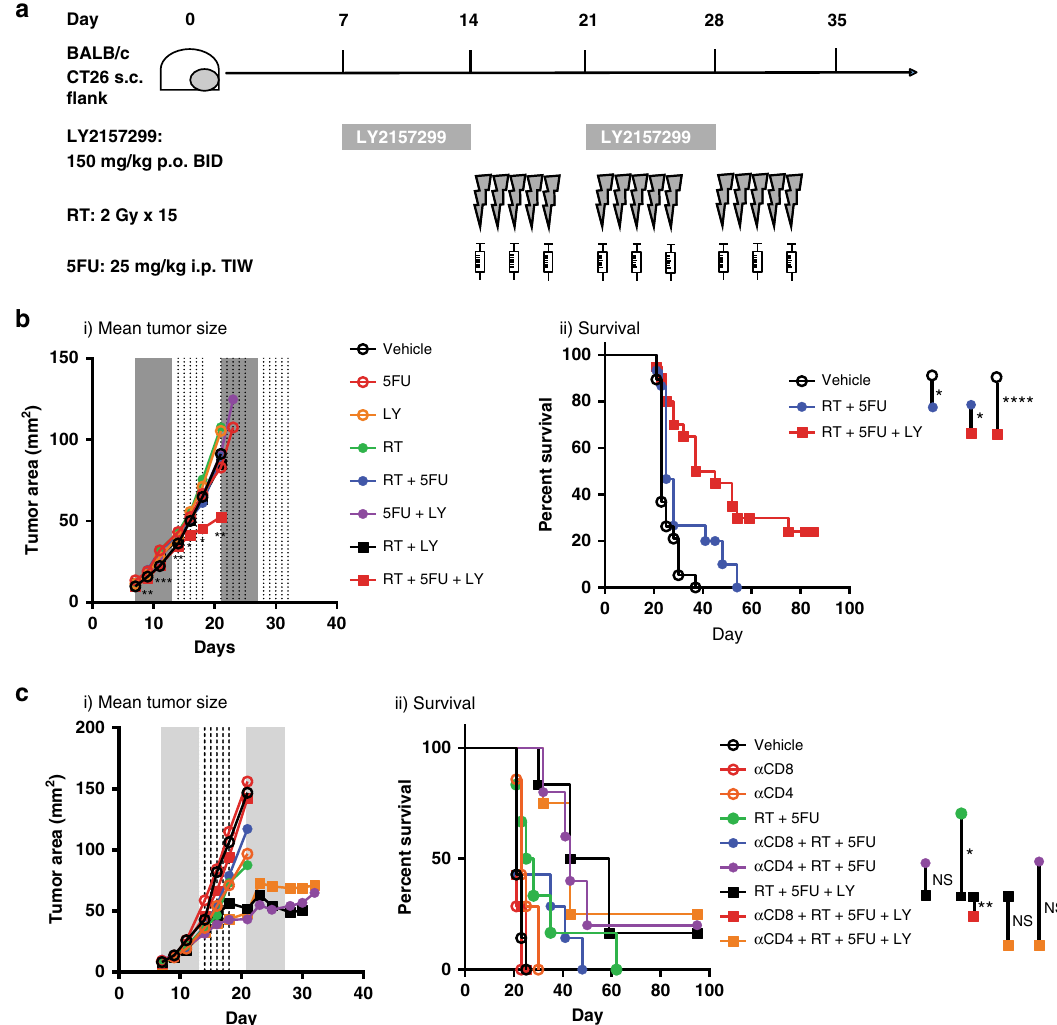
Fig. 1 Enhancement of chemoradiation ef fi cacy by the TGF β RI inhibitor, LY2157299, depends on CD8 α + cells in CT26 tumors. a Treatment schema in the CT26 tumor model. Six to eight-week-old BALB/c mice were implanted subcutaneously in the left fl ank with 2 × 10 5 CT26 tumor cells. Seven days following implant animals were randomized based on tumor size; vehicle control or LY2157299 (LY) compound were administered by oral gavage twice daily every 12 h at 150 mg/kg for 7 consecutive days. At day 14, some mice received 15 radiation treatments of 2 Gy, delivered Monday through Friday, targeted to tumor tissue along with 25 mg/kg injections of 5- fl uorouracil (5FU) chemotherapy administered intraperitoneally on days 14, 16, and 18. LY treatment groups resumed BID oral dosing from days 21 – 27. b Mean tumor growth (i) and survival (ii) measured 3 times per week up to 100 days or death. For (i), p-values are a comparison between RT + 5FU (blue dots) and RT + 5FU + LY (red squares) using an unpaired, two-tailed t -test, and values are as follows for days 7 – 21: 0.059 (NS), 0.0086 (**), 0.0001(***), 0.0048 (**), 0.039(*), 0.042(*), 0.0068(**). For (ii), p -values for survival were derived using log-rank test. Vehicle (open circle) vs. RT + 5FU = 0.023(*), vehicle vs. RT + 5FU + LY < 0.0001(****), RT + 5FU vs. RT + 5FU + LY = 0.015(*). Displayed is a combined results of 3 independent experiments with n = 15 mice/group. c Mean tumor size (i) and survival (ii) of CT26 tumor-bearing mice receiving the indicated treatment combinations, with RT dose of 5 Gy × 5 consecutive fractions, and either anti-CD4 or anti-CD8 α monoclonal antibodies to deplete CD4 + and CD8 α + cells prior to therapy. The legend key for each group is located next to the survival curve. NS = not signi fi cant, * p = 0.0448, ** p = 0.0011. P -value was derived using the Wilcoxon test. N = 6 mice/group. Displayed is one representative experiment of 2 total